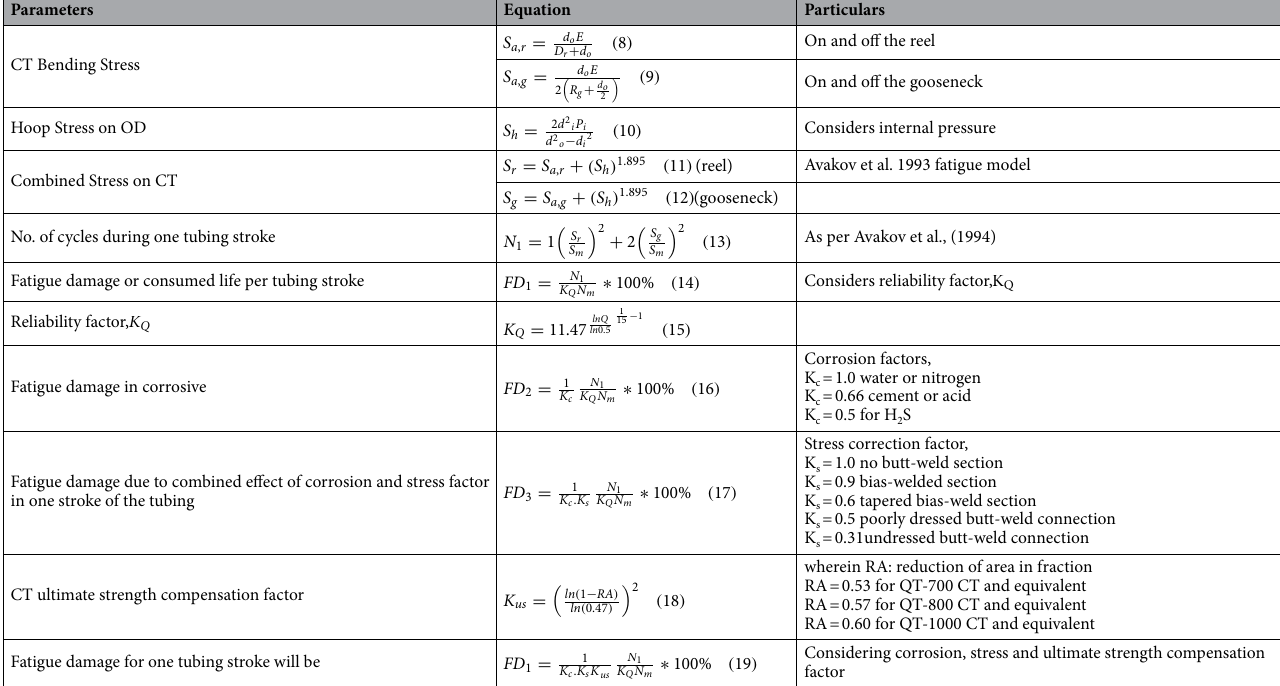
Table 2. Mathematical expressions for estimating CT fatigue Life 6